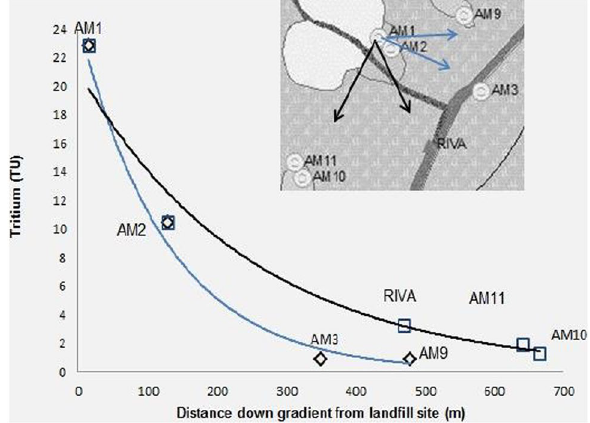
Fig. 5 Tritium activities variation with distance down gradient the landfill